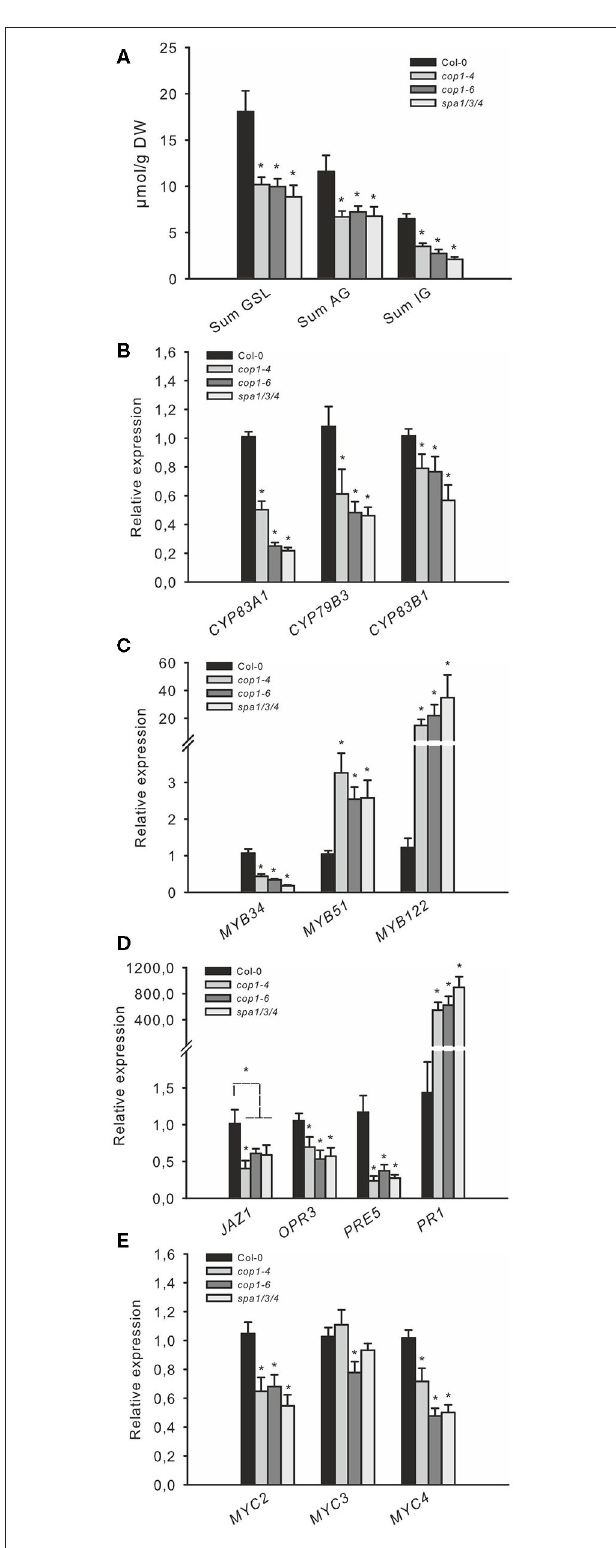
FIGURE 2 | The COP1/SPA complex regulates jasmonate (JA) signaling-dependent GSL regulation. The levels of GSL (A) and the